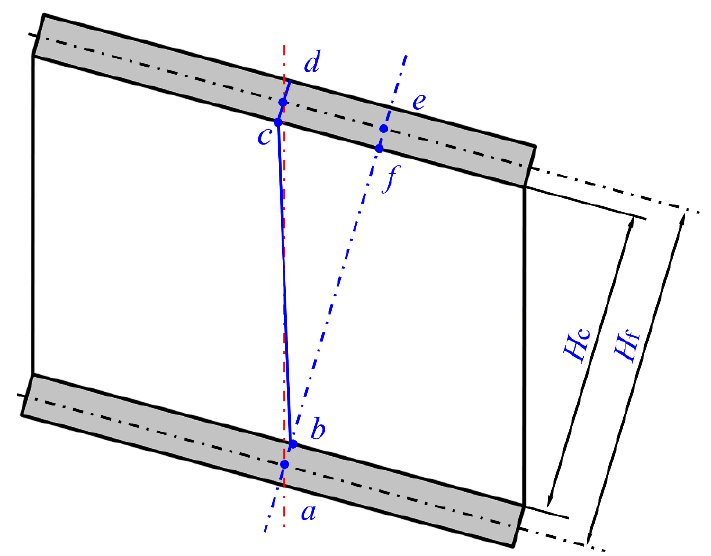
Figure 9. Shearing deformation sketch of lattice core.